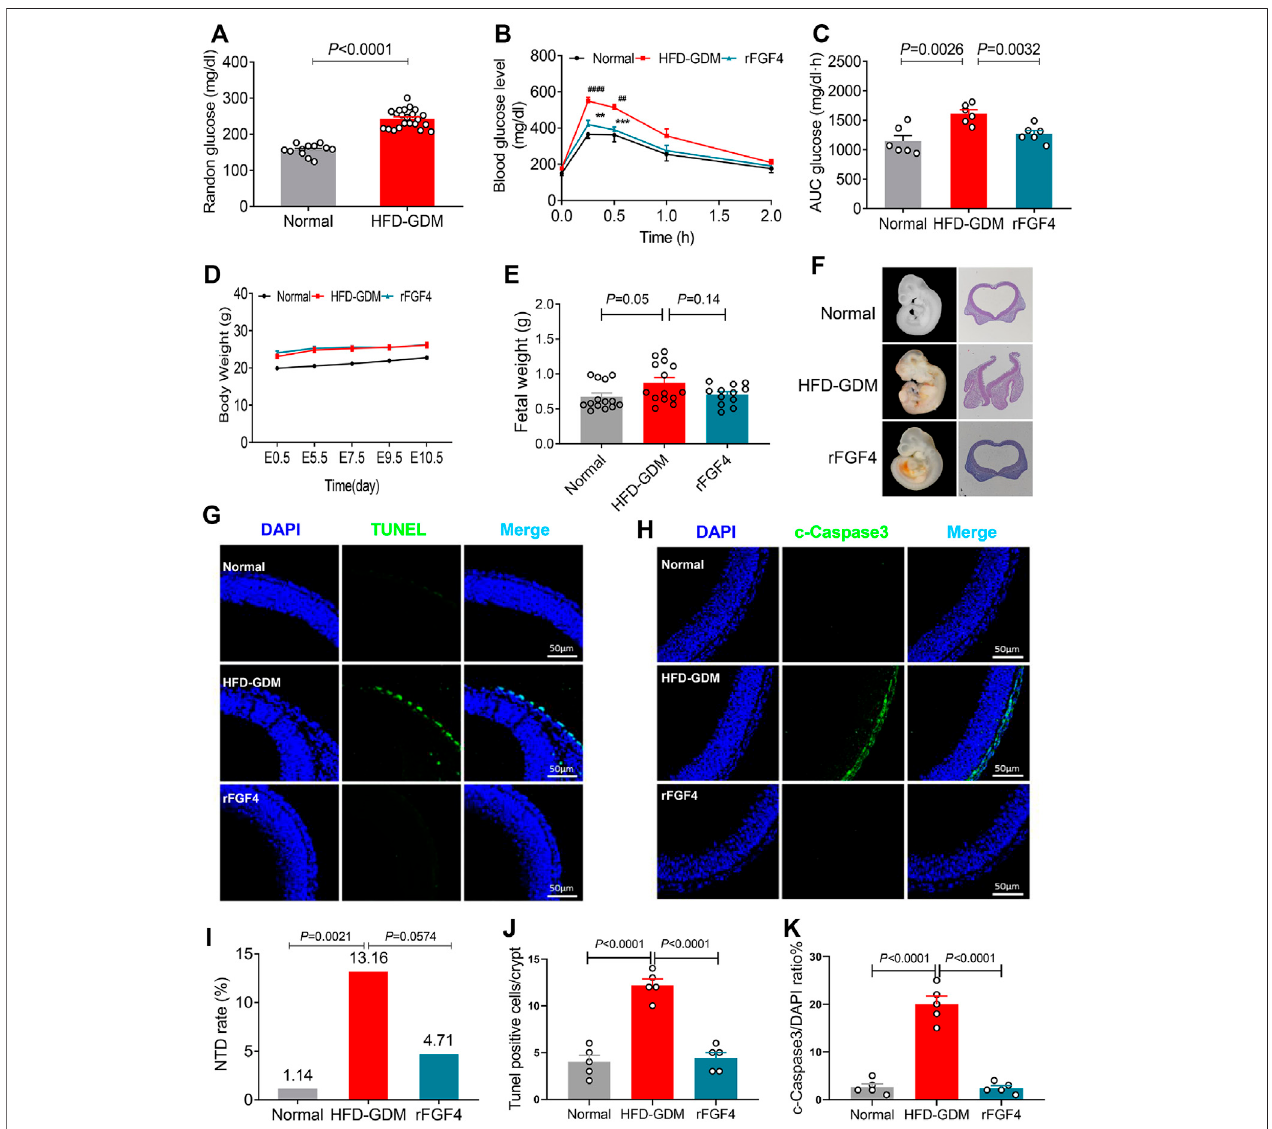
FIGURE4| rFGF4treatmentnormalizestheadversemetabolicphenotypesandalleviatesmaternalHFD – inducedNTDformation. (A) Randombloodglucoselevels of the normal and HFD-GDM mice ( n = 10 – 11). (B – C) A glucose tolerance test (GTT) done (B) and the accompanying integrated area under curve (AUC) for changes in blood glucose (C) at E9.5 ( n = 6). ## p < 0.01, #### p < 0.0001 versus normal mice control; ** p < 0.01, *** p < 0.001 versus HDF-GDM mice. (D) Body weight changes of each group mice. (E) Embryos weight at E17.5 ( n = 4). (F) Representative closed and open neural tube structures of E10.5 embryos from control, HFD induced GDM and rFGF4-treated mice. (G,J) Representative images of the TUNEL assay showing apoptotic cells (green signal) and quanti fi cation of TUNEL positive cells in (G) . Cell nuclei were stainedwithDAPI (blue). Scale bar = 50 μ m. ( n =5). (I) NTDformationratesofembryosfrom control, HFD induced GDM and rFGF4-treated mice. (H,K) Representative immuno fl uorescence staining and quanti fi cation of cleaved-Caspase 3 in E10.5 embryos from control, HFD induced GDM and rFGF4-treated mice. Scale bar = 50 μ m ( n = 5).